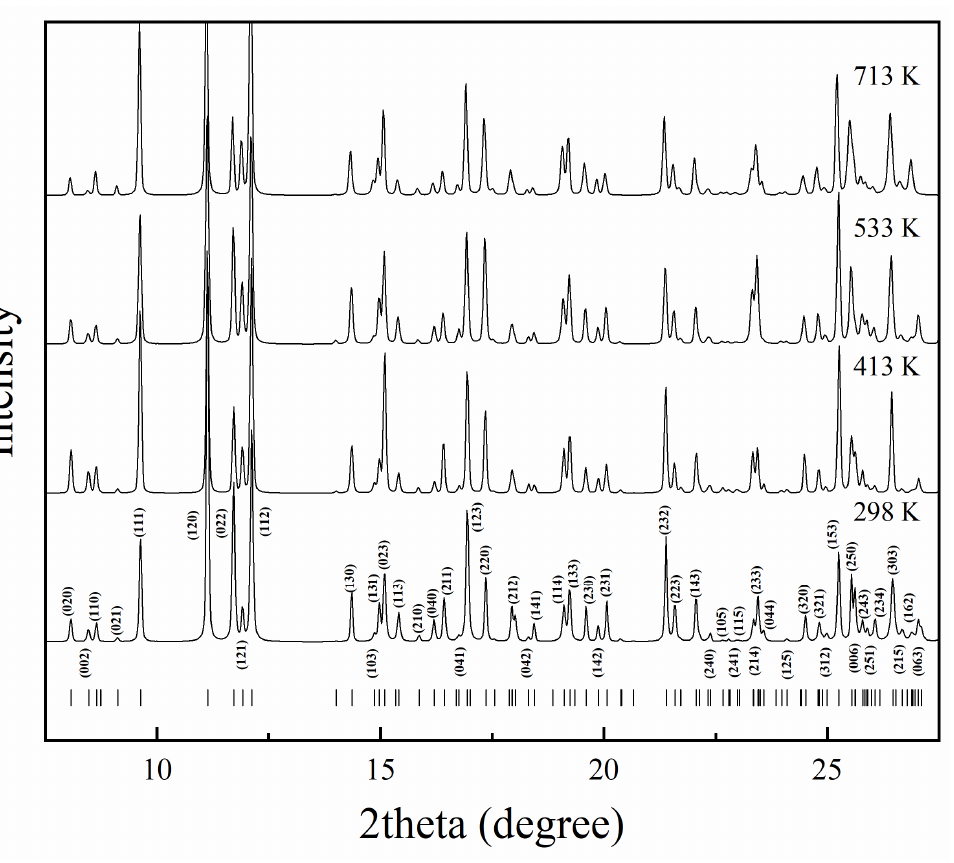
Figure 6. Typical X-ray di ff raction patterns of topaz from powder X-ray di ff raction experiments at Figure 6. Typical X ‑ ray diffraction patterns of topaz from powder X ‑ ray diffraction experiments at ambient pressure and high ambient pressure and high temperature.